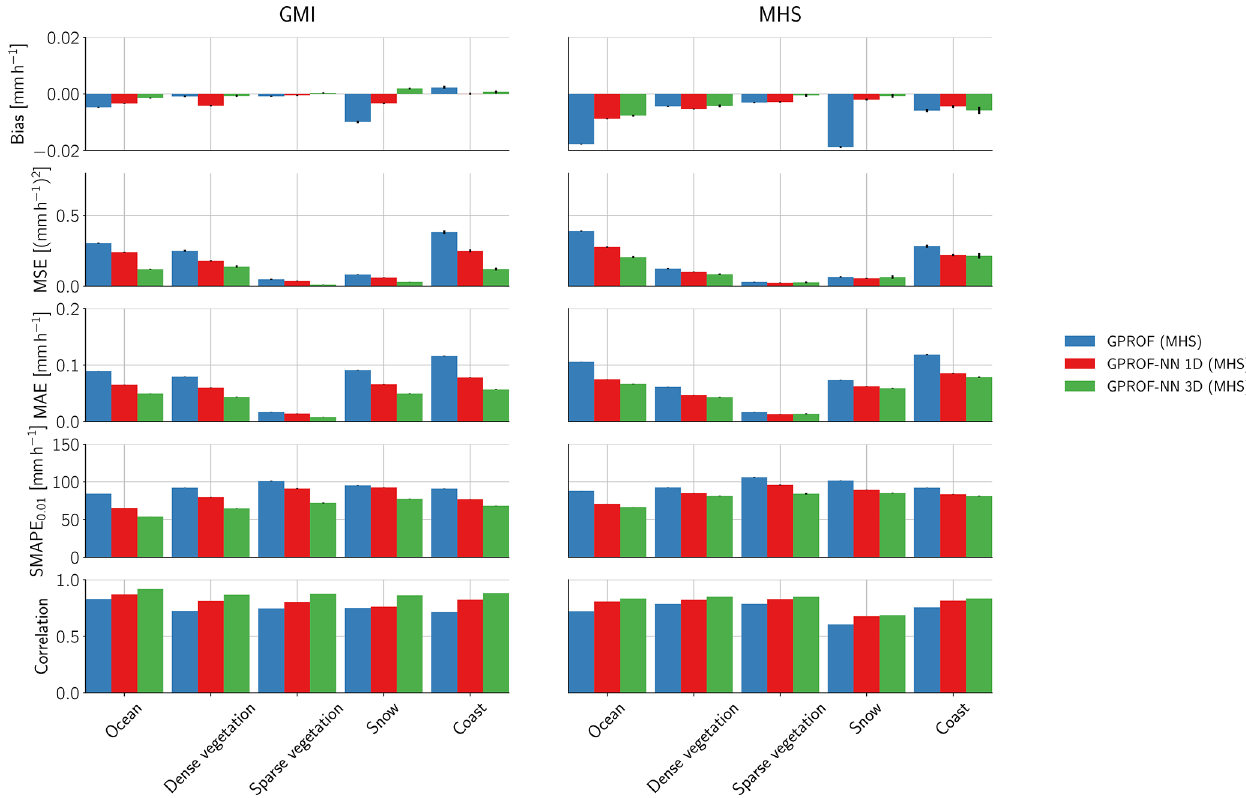
Figure 7. Bias, MSE, MAE, SMAPE 0 . 01 , and correlation of the retrieved surface precipitation with respect to the surface type and retrieval algorithm. The results for the GMI sensor are displayed in the first column, and results for the MHS sensor are displayed in the second column. Error bars mark one standard deviation around the mean.